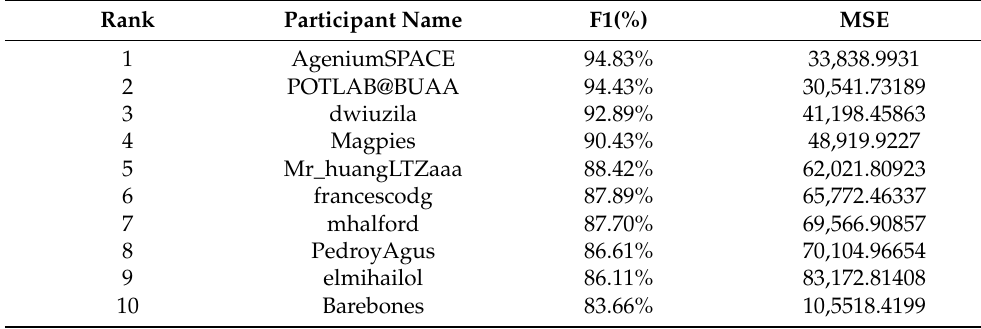
Table 4. Final ranking of top 10 teams in the SpotGEO challenge.